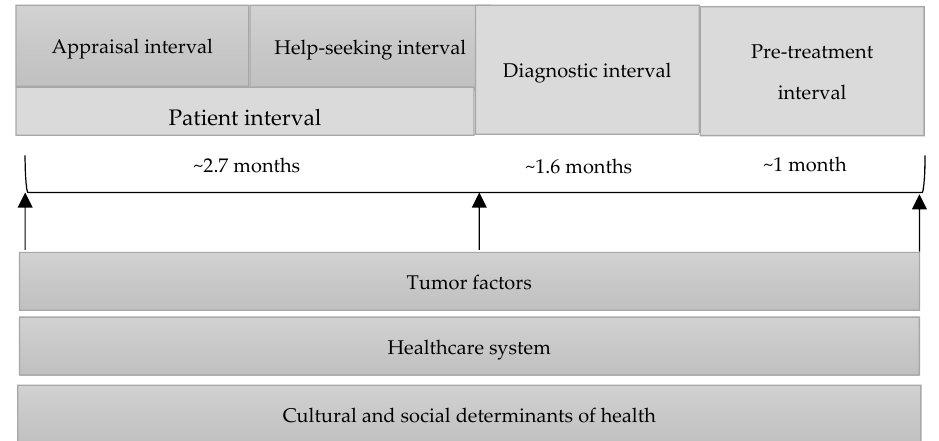
Figure 1. Time-intervals in the pathway of diagnosis and treatment of oral